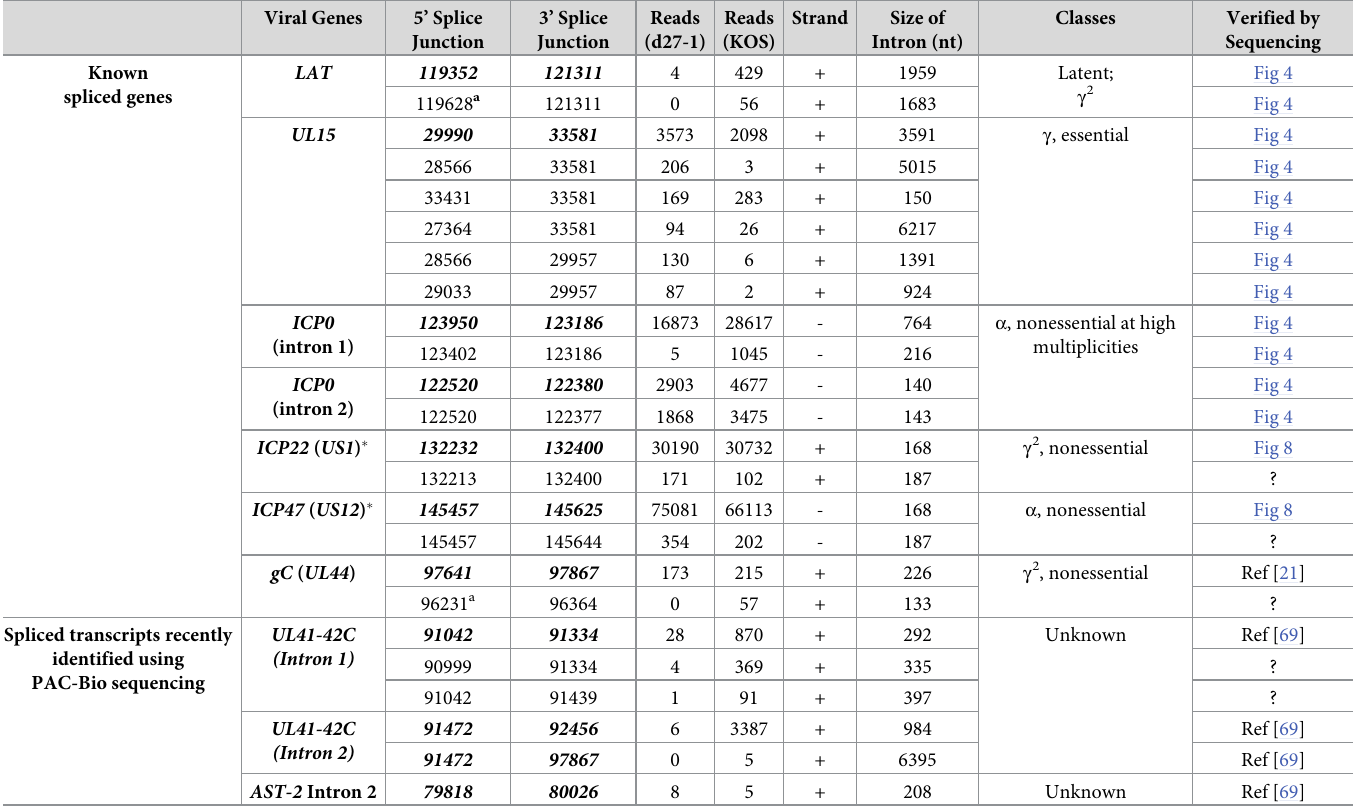
Table 1. List of splice sites of previously known spliced genes and transcripts identified in the ICP27 mutant virus and wild-type HSV-1 (KOS) infected cell. Viral Genes 5’ Splice 3’ Splice Junction Junction Known spliced genes